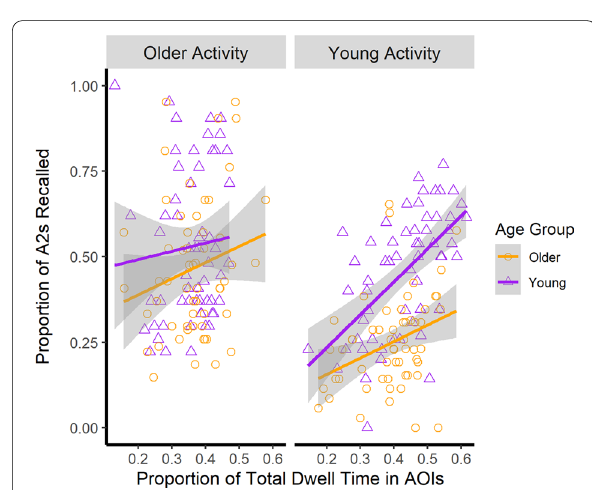
Fig. 8 Proportion of A2s recalled as a function of the proportion of time spent in the AOIs, activity, and age group. Raw values for each participant are represented by the points in the figure. Activity type is represented in the panels. Lines represent the predicted least square means generated from the estimated regression equation. The proportion of total dwell time in the areas of interest positively predicted event memory. Error ribbons correspond to 1 standard error around the line of best